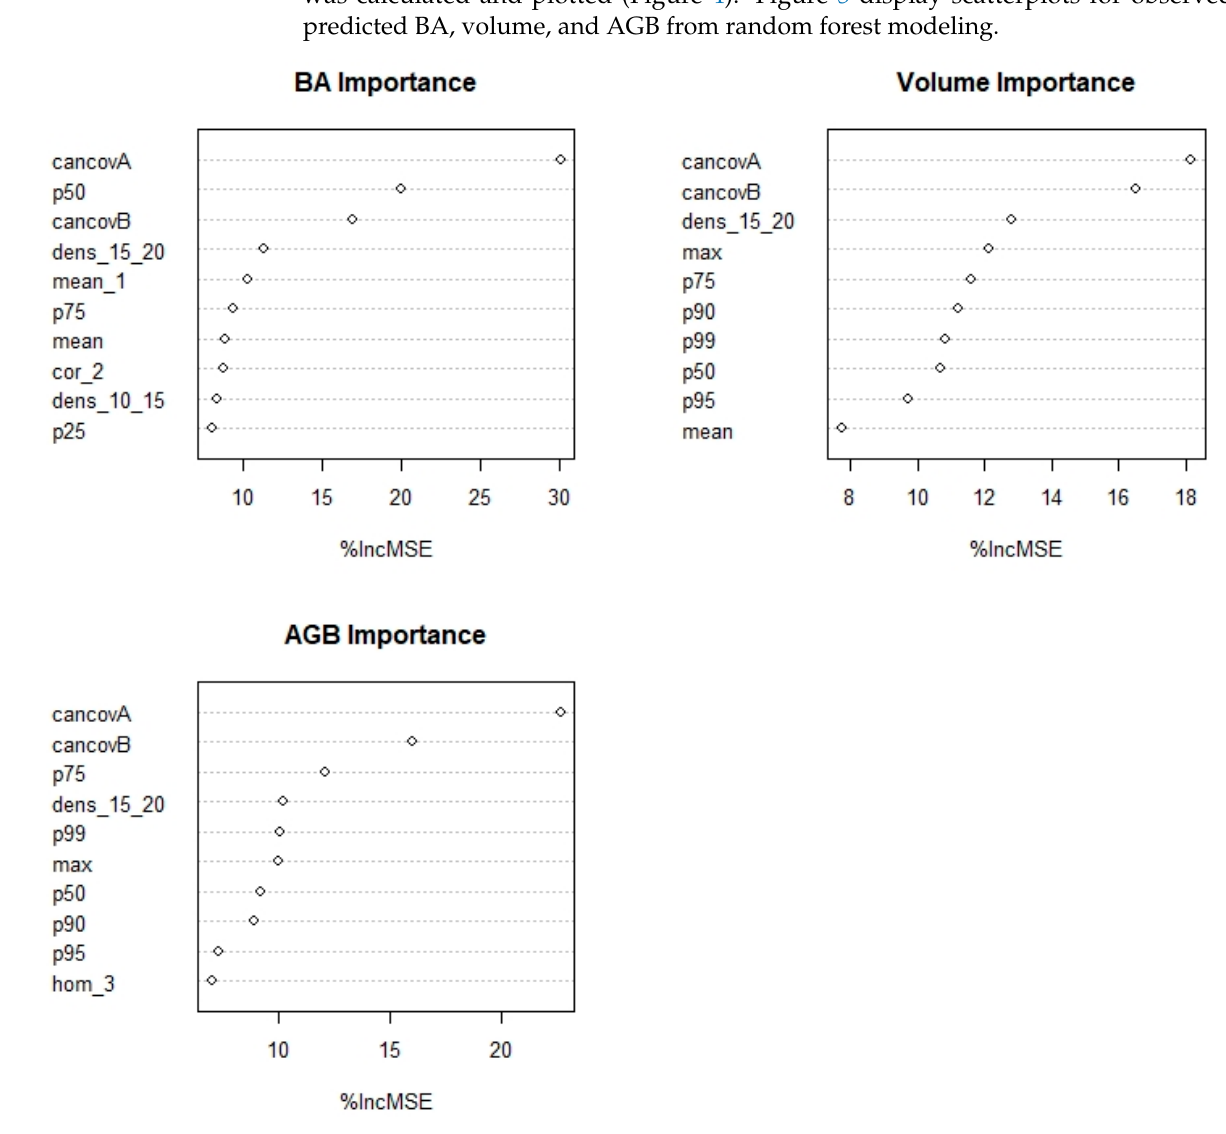
Figure 4. Importance plots for variables used in RF